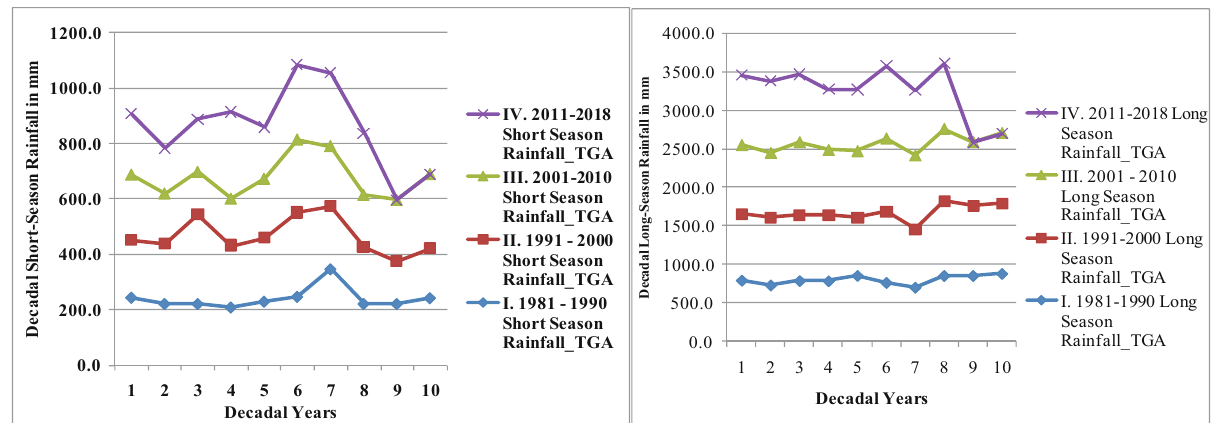
Table 1: Linear trend determinant of rainfall te ff growing areas of Ethiopia ( 1981 – 2018 ) Variables β ( slope ) St. error t - stat Adjusted R 2 PIF Short - season rainfall_TGA − 0.472 0.658 − 0.718 − 0.013 1.000 Long - season rainfall_TGA 2.868** 0.900 3.187 0.20 1.000 **Indicates 10% level of signi fi cance.